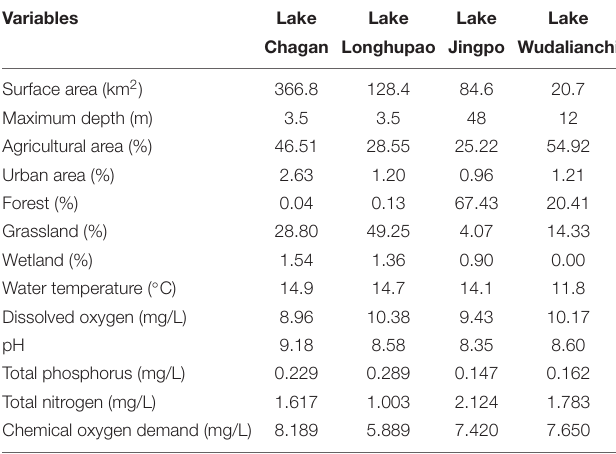
TABLE 1 | Information on watershed land use and environmental gradient parameters in four selected lakes.